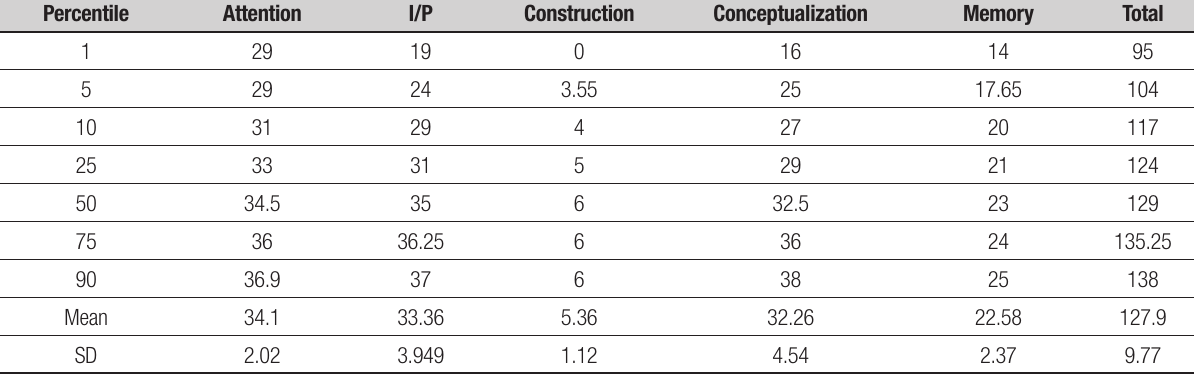
Table 4. Percentiles for subjects with 1-4 years of schooling and 61 to 70 years of age (n=57). Percentile Attention